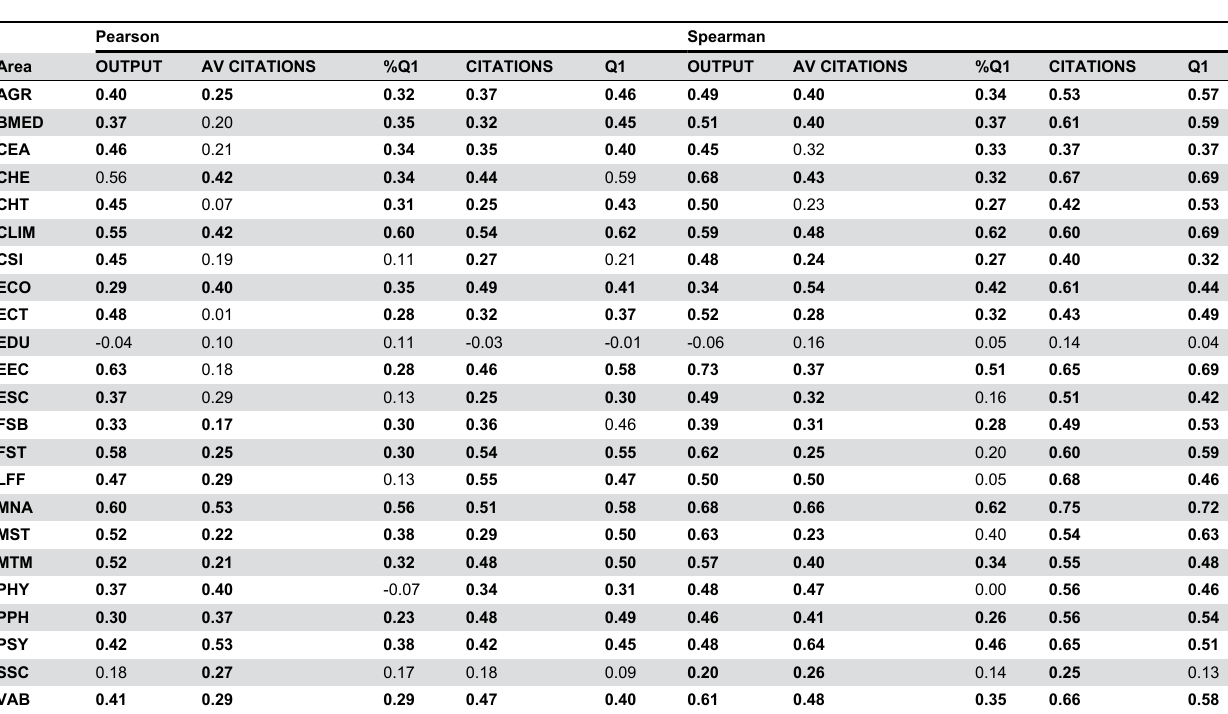
Table 6. Pearson’s and Spearman’s correlation coefficient between bibliometric indicators and PIs’ CV ratings by research